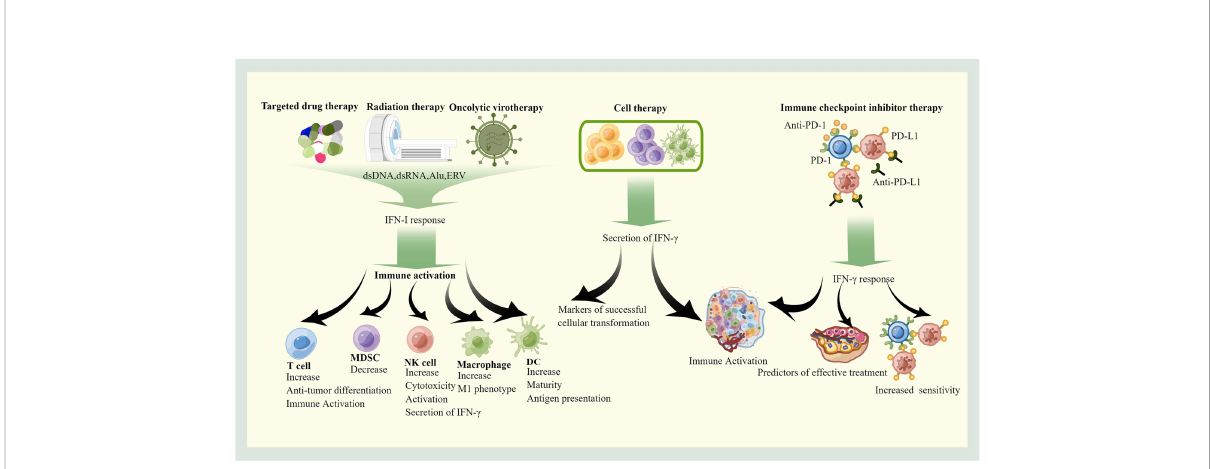
FIGURE 3 The roles of IFNs in therapy. Targeted therapy, radiotherapy and Oncolytic virotherapy stimulate the immune system of OC mainly through the IFN-I pathway, which promotes the recruitment and activation of pro-immune cells. Cell therapy can autonomously secrete IFN- g to exert anti- cancer effects, and immune checkpoint inhibitor therapy requires indirect induction of IFN- g production through feedback from immune checkpoints. The produced IFN- g helps the formation of immune-friendly microenvironment, and high IFN- g is associated with good prognosis. This picture is drawn with the help of